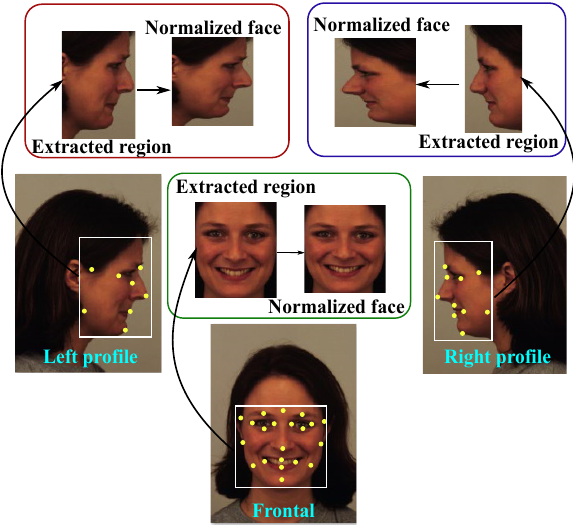
Figure 3. Face pre-processing steps in the proposed